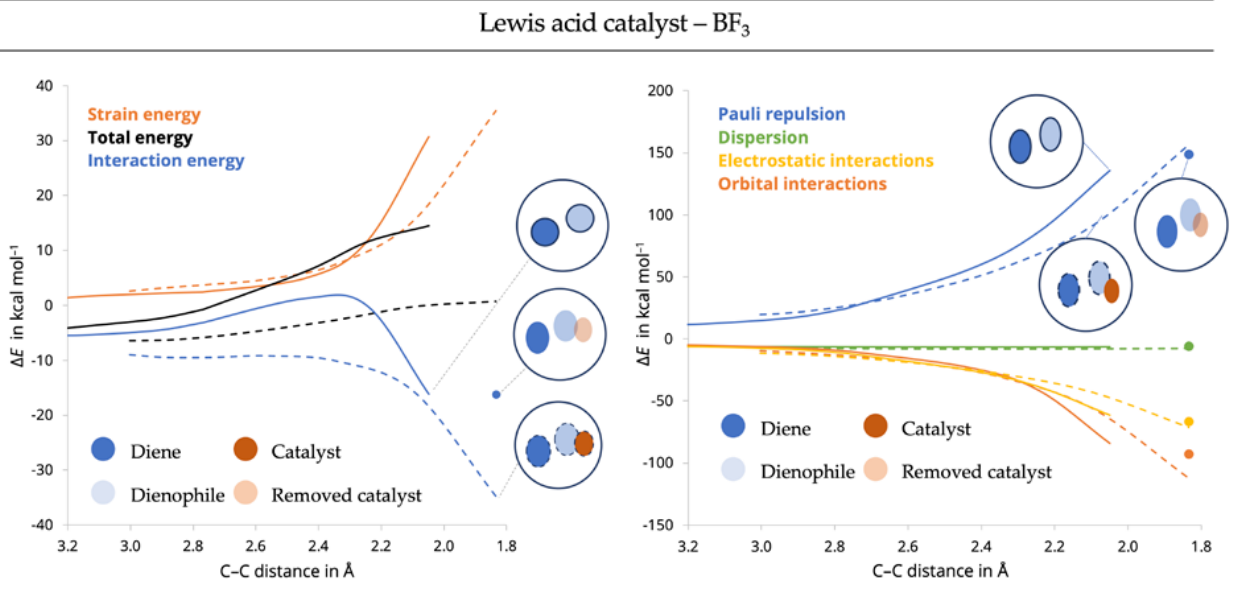
Figure 3. ASM ( left ) and EDA ( right ) analysis of the uncatalyzed and BF 3 -catalyzed reactions between benzaldehyde and 2,3-dimethyl 1,3-butadiene. The solid line represents the reaction without the catalyst, and the dashed line represents the reaction with the catalyst. The dots represent the values for the transition-state geometry of the catalyzed reaction with the catalyst deleted. Pictograms symbolize the system considered.